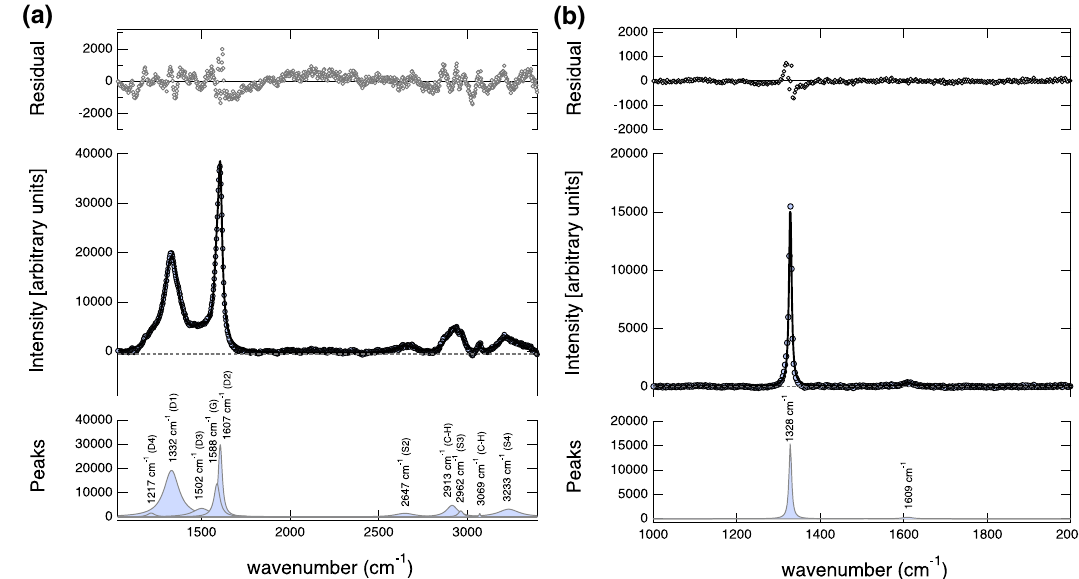
Figure 5. Raman spectra of carbonaceous materials after the devolatilization of the carbonate-bearing chrysotile sample. ( a ) Deconvolution of Raman spectra shows graphite and C–H stretching modes likely indicating CH 4 . The vibrational modes are characterized by first-order bands of ordered graphite at 1588 cm −1 (G) and disordered graphite bands at 1217 cm −1 (D4) , 1332 cm −1 (D1), 1502 cm −1 (D3) and 1607 cm −1 (D2) 46 . The second-order overtones of graphite bands are less intense compared to the primary modes and are observed at 2647 cm −1 (S2), 2962 cm −1 (S3), and 3233 cm −1 (S4) 46 . Additional bands are also identified at 2913 cm −1 and 3069 cm −1 and are likely due to C–H stretching 50 . ( b ) Raman spectrum showing an intense and sharp mode at ~ 1328 cm −1 indicative of crystalline diamond 48 which may have formed in the C–H–O